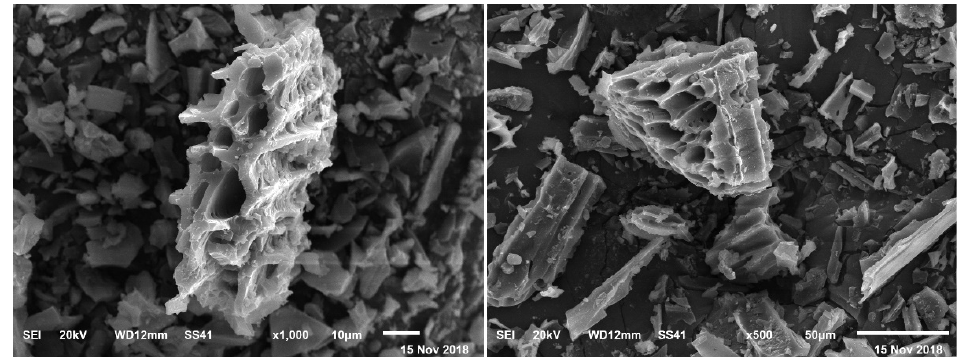
Figure 1. Image of scanning electron microscope of corncob biochar used in the lysimeters experiment.